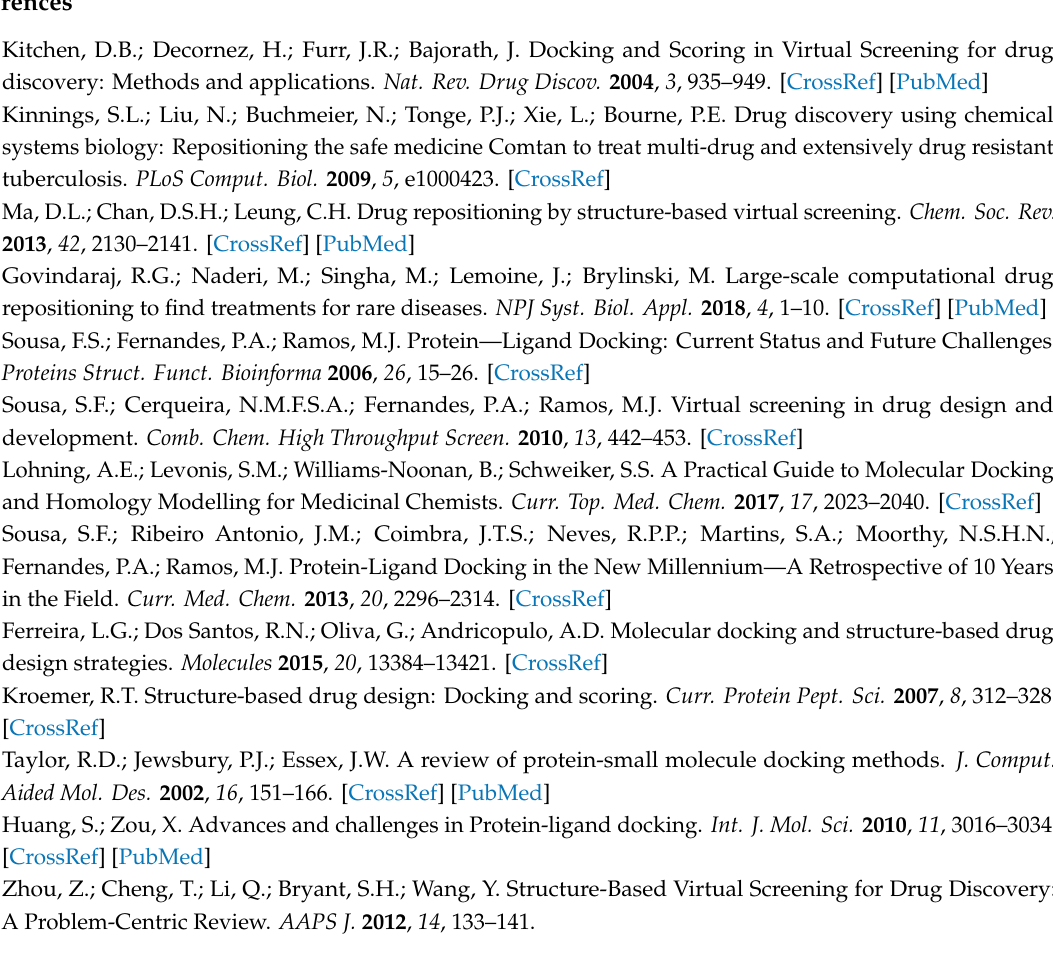
Table S1: Docking parameters used for Vina and AutoDock; Figure S2: Comparison between the crystallographic (green) and “docked” (purple) poses for Vina and AutoDock to evaluate the influence of the number of rotational bonds in pose prediction. (a) Ligands with the lowest number of rotational bonds. (a1) Ligands with the highest number of rotational